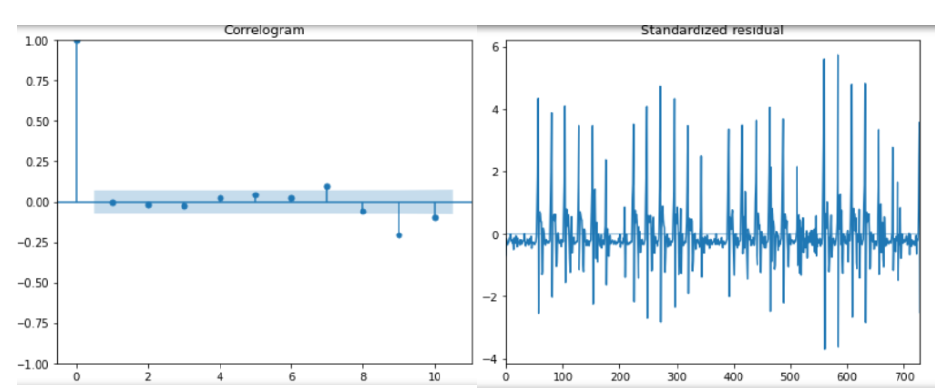
Figure 19. The standardized residual and